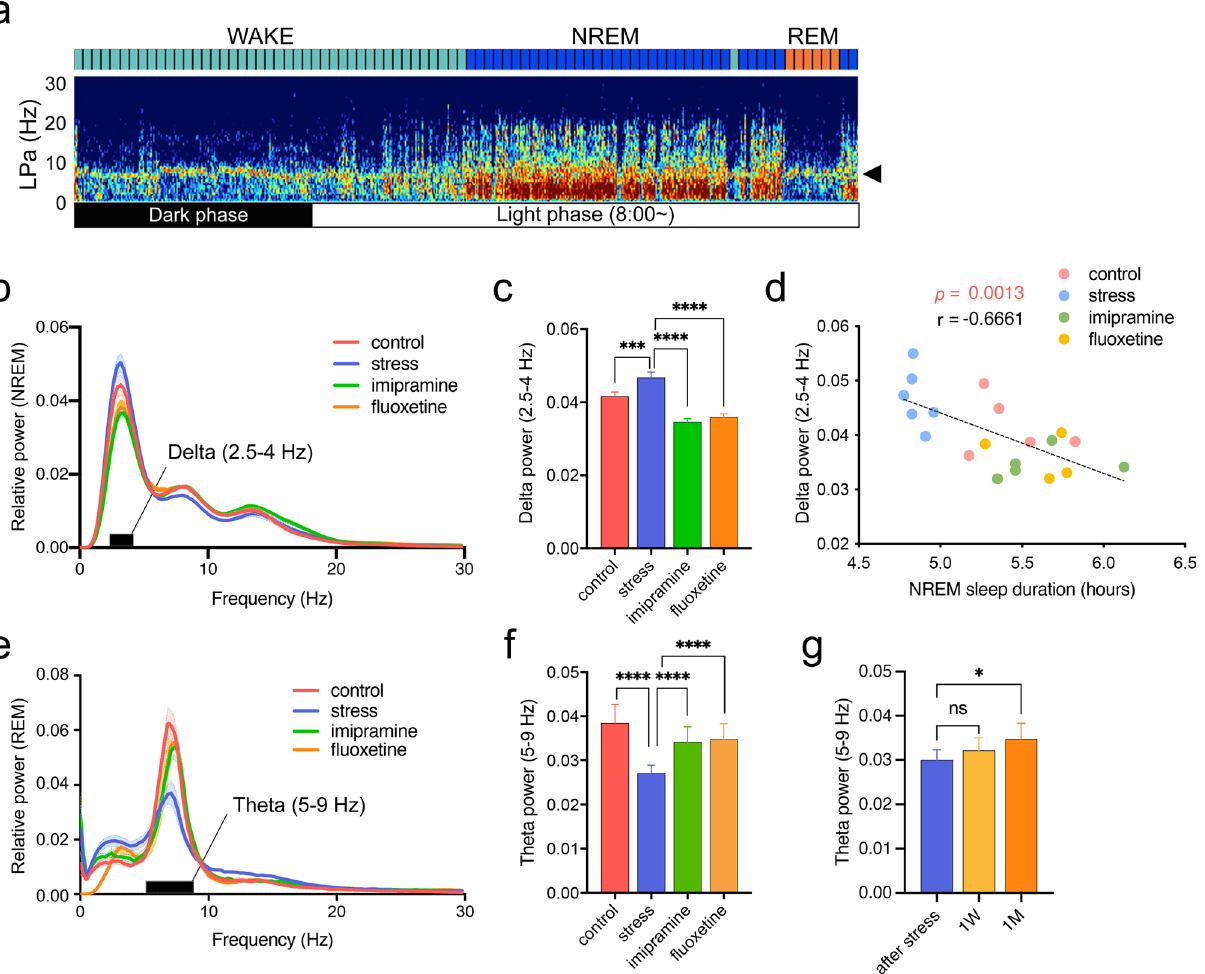
Figure 4. Effects of social defeat stress (SDS) and chronic antidepressant (AD) treatment on electroencephalography (EEG) spectral power. ( a ) A representative spectrogram showing the predominant frequency band at the theta range (arrowhead) during wakefulness and rapid eye movement (REM) sleep (30 s/ epoch). ( b ) EEG-relative power spectra during NREM sleep in the light phase (ZT0–ZT8.5). The black bar indicates the selected delta (2.5–4 Hz) band. ( c ) Average relative spectral power of the delta band during NREM sleep. F (5, 96) = 5.638, p = 0.0001, *** p < 0.0005, **** p < 0.0001, two-way analysis of variance (ANOVA) followed by Tukey’s multiple comparisons test. ( d ) A significant negative correlation between NREM sleep duration during the light phase and the relative delta power (2.5–4 Hz). p = 0.0013, r = −0.6661. ( e ) Relative power spectra during REM sleep in the light phase. The black bar shows the selected theta (5–9 Hz) band. ( f ) Average relative theta power during REM sleep. F (45, 256) = 3.033, p < 0.0001, * p < 0.05, ** p < 0.005, **** p < 0.0001, two-way ANOVA followed by Tukey’s multiple comparisons test. ( g ) Time-dependent effects of fluoxetine (FLU) on average relative spectral powers during REM sleep. F (15, 144) = 18.28, p < 0.0001, * p < 0.05, two-way ANOVA followed by Tukey’s multiple comparisons